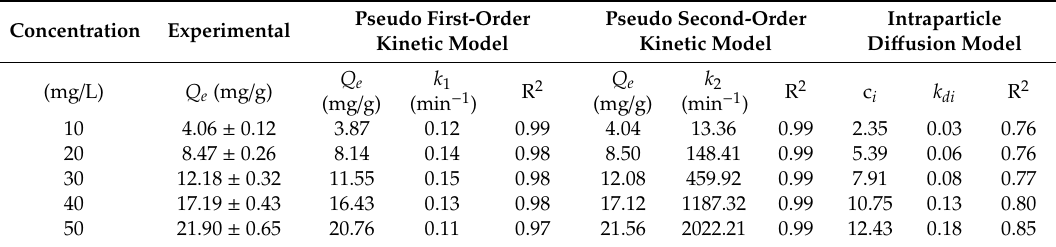
Table 3. Experimental data and model parameters for the adsorption of SF from pseudo first-order kinetic, pseudo second-order kinetic, and intraparticle di ff usion models at di ff erent dye concentrations.